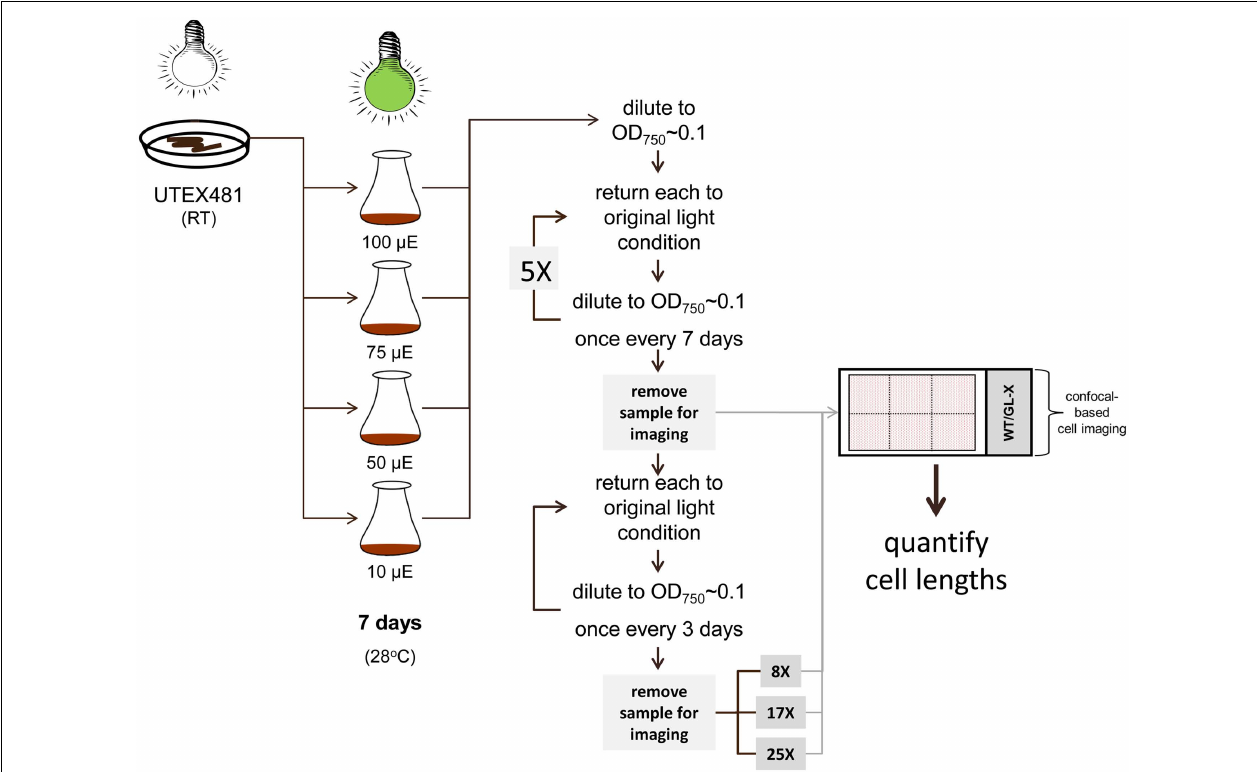
at room temperature (RT). Replicate liquid cultures at an absorbance at 750nm (OD 750 ) of ∼ 0.1 were grown under GL at 10, 50, 75, or 100 μ molm − 2 s − 1 at 28˚C with shaking at ∼ 175rpm for 7days. Cultures were then diluted to an OD 750 of ∼ 0.1 every 7days for five consecutive dilutions, followed by dilution to OD 750 of ∼ 0.1 every 3days. Cells were prepared for imaging after 5th, 8th, 17th, and 25th dilutions.